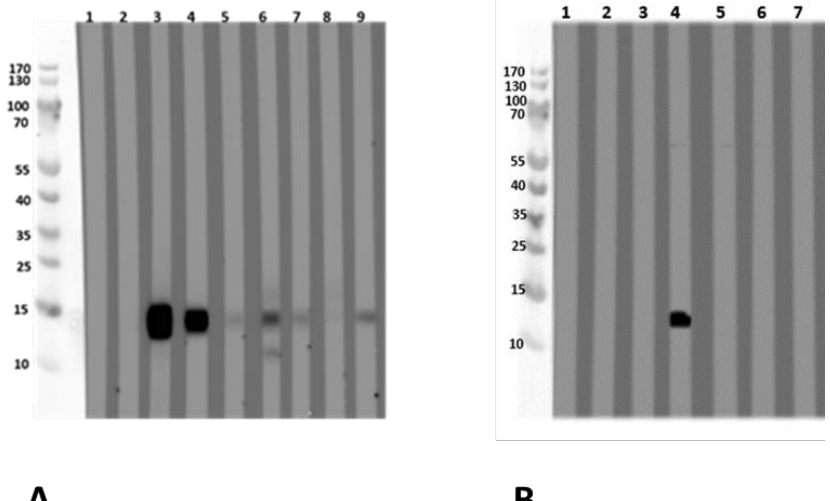
Figure 3. Immunoblot with ( A ) recombinant L. albus profilin and ( B ) with natural L. albus extract. ( A ) (1) Tris (buffer negative control) (2) negative serum; (3) peanut allergy, lupine-sensitized (P 11); (4) peanut allergy, lupine-sensitized (P 12); (5) suspected lupine allergy (P 14); (6) peanut allergy, lupine-sensitized (P 13); (7) peanut and lupine allergy (P 15); (8) peanut allergy, lupine-sensitized (P 16); (9) peanut allergy, lupine-sensitized (P 17). ( B ) The immunoblot was designed as an inhibition assay using natural L. albus extract and sera pre-incubated with different concentrations of recombinant L. albus profilin using one profilin-reactive serum (4). (1) Tris, (2) negative serum, (3) negative serum + 50 µ g rProfilin, (4) serum 4 (P 12), (5) serum 4 + 5 µ g rProfilin, (6) serum 4 + 50 µ g rProfilin, (7) serum 4 + 500 µ g lupine extract. Blocking was performed with Synblock; serum dilution was 1:20, dilution of the HRP-conjugated mouse-anti-human IgE Fc-antibody was 1:5000 (SouthernBiotech, Birmingham, AL, USA). Immunologically, the recombinant profilin performed similarly to the natural allergen. P-code refers to Table